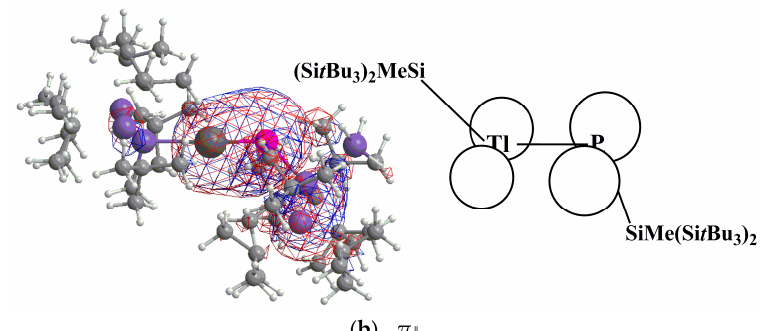
Figure 5. The natural Tl ≡ P π bonding orbitals (( a ) and ( b )) for (SiMe(Si t Bu 3 ) 2 )Tl ≡ P(SiMe(Si t Bu 3 ) 2 ). For comparison, see also Figure 3. Table 3. The charge decomposition analysis (CDA) (a) for R ′ Tl ≡ PR ′ (R ′ = SiMe(Si t Bu 3 ) 2 ) system based on M06-2X orbitals, where the X term indicates the number of electrons donated from R ′ ⎼ Tl fragment to R ′ ⎼ P fragment, the Y term indicates the number of electrons back donated from R ′ ⎼ P fragment to R ′ ⎼ Tl fragment and the Q term indicates the number of electrons involved in repulsive polarization. Significant X and Y terms are bolded for easier comparison. (a),(b)